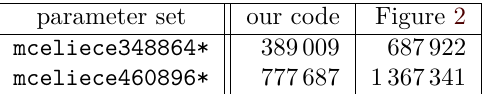
Table 5: Cycle counts for computing T · e (1)